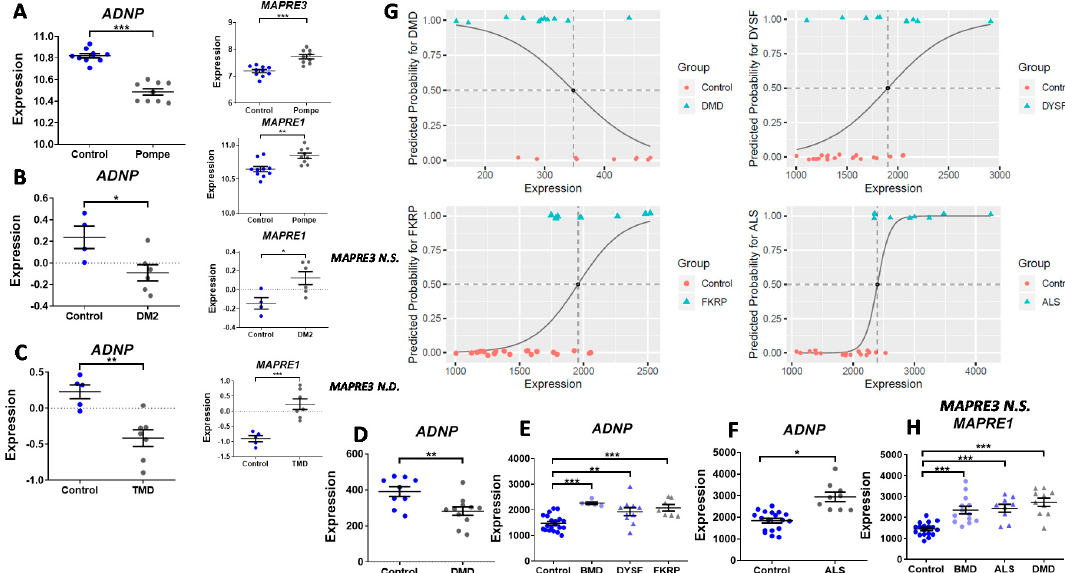
Figure 2. ADNP is dysregulated in different neuromuscular disorders. ( A – D ) ADNP was significantly downregulated in various muscle types: bicep, quadriceps, vastus lateralis and distal muscles from patients with a range of neuromuscular disorders: Pompe n = 9 (control n = 10, GSE38680), DMD n =